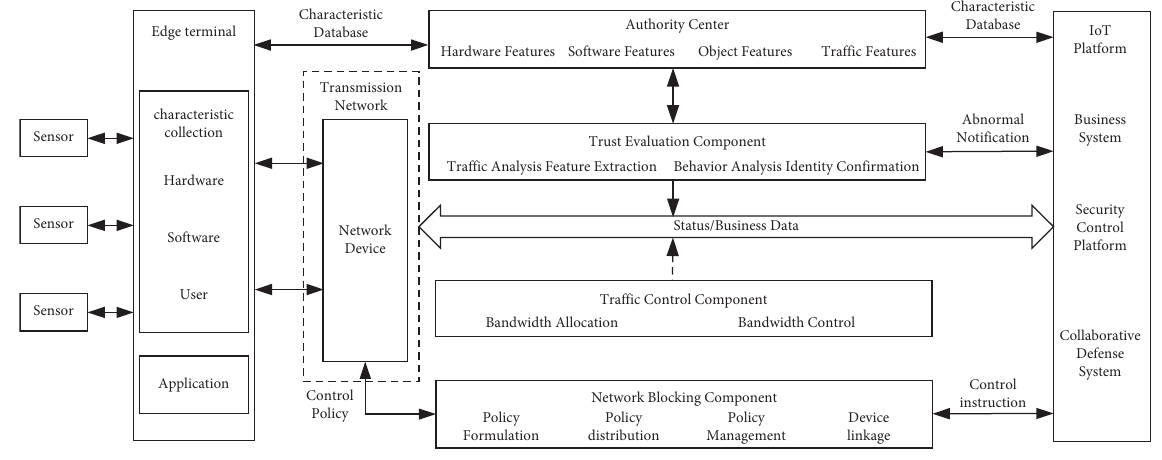
Figure 3: Te ZTF in the power IoT.